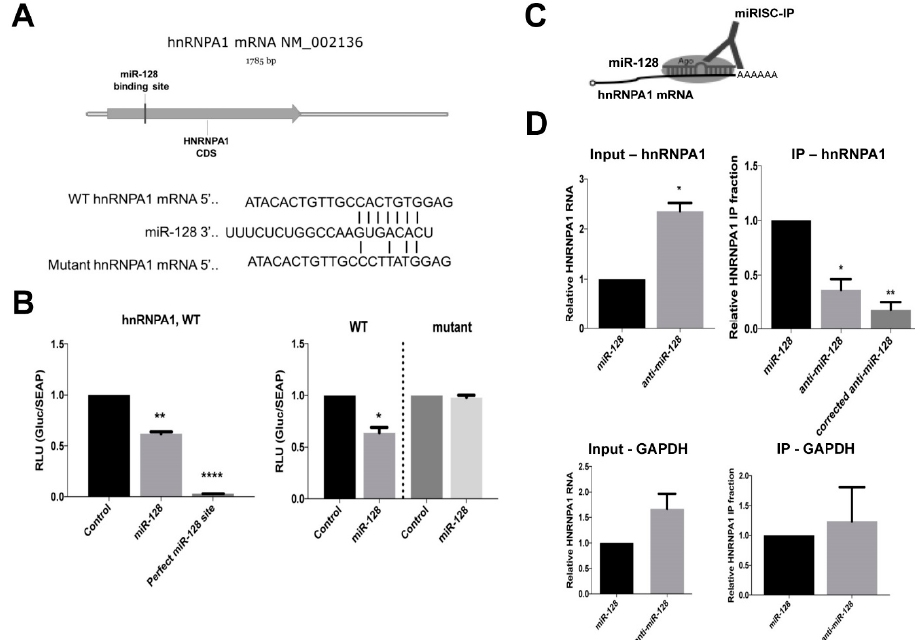
Figure 3. miR-128 represses hnRNPA1 expression by binding directly to coding sequence (CDS) RNA. ( A ) Schematic of the predicted miR-128 7-mer binding site in the coding region (CDS) of hnRNPA1 mRNA (top panel). ( B ) Cartoon showing the predicted base pairing of miR-128 to the seed sequence of wild-type (WT) hnRNPA1 as well as a representation of mutations in the seed sequence (mutant) used for luciferase binding assays (top panel). Relative luciferase activity in HeLa cells transfected with plasmids expressing a Gaussia luciferase gene fused to the wild-type (WT) binding site or positive control sequence corresponding to the 22 nucleotide perfect match of miR-128 and co-transfected with control or mature miR-128 mimics were determined 48 h post-transfection (bottom left panel, n = 3 independent biological replicates, mean ± SEM, ** p < 0.01, **** p < 0.0001). Relative luciferase activity in HeLa cells transfected with plasmids expressing the luciferase gene fused to the WT or the mutated binding site (mutant) and co-transfected with control or mature miR-128 mimics were determined 48 h post-transfection (bottom right panel, n = 3 independent biological replicates, mean ± SEM, * p < 0.05). ( C ) Cartoon of Argonaute-RNA immuno-purification (miRISC-IP). ( D ) miRISC IP of HeLa cell lines stably transduced with miR-128 overexpression or miR-128 neutralization (anti-miR-128) were performed. Relative amounts of hnRNPA1 RNA normalized to B2M were determined for input samples (top left panel “input—hnRNPA1”, n = 3 independent biological replicates, mean ± SEM, * p < 0.05). Relative fractions of hnRNPA1 transcript amounts associated with immune-purified Ago complexes are shown for immunopurified (IP) samples, hnRNPA1 fractions normalized to the amount of TNPO1 in the input are shown as “corrected” (top right panel “IP—hnRNPA1”, n = 3 independent biological replicates, mean ± SEM, * p < 0.05, ** p < 0.01). ( D ) Relative amount of GAPDH in the same input and IP samples were determined as a negative control (top right panel “IP—hnRNPA1”, n = 3 independent biological replicates, mean ± SEM). Throughout the figure, n = 3 independent biological replicates, mean ± SEM, * p < 0.05, ** p < 0.01, **** p < 0.0001, calculated by students t-test. Finally, in order to evaluate whether miR-128 directly interacts with hnRNPA1 mRNA in cells, Argonaute-RNA immuno-purification (miRISC-IPs) analysis were performed, see Figure 3C. Briefly, transduced HeLa cell lines stably expressing miR-128 or anti-miR-128 were lysed and Argonaute complexes relatively enriched with miR-128 (miR-128) or depleted of miR-128 (anti-miR-128) were